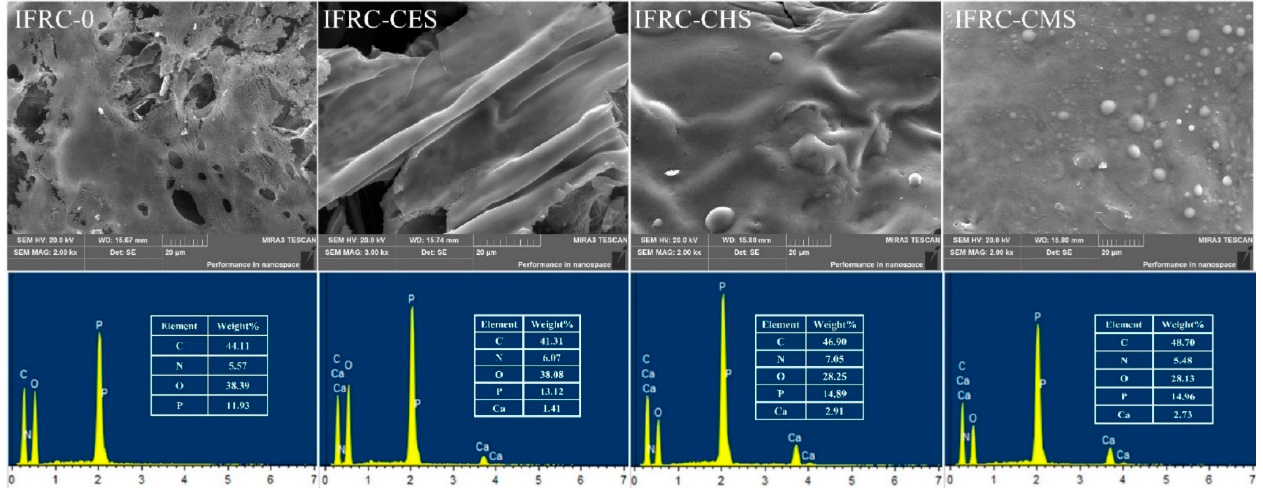
Figure 7. SEM images and EDS maps of the char residues obtained from the big panel method test.